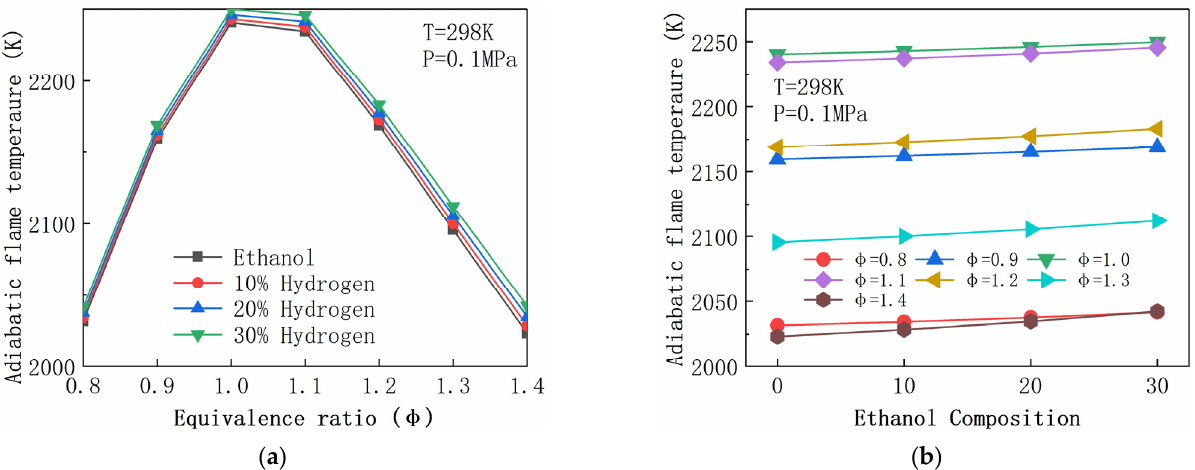
Figure 9. The AFT of ethanol − hydrogen − air flames at various ERs. ( a ) Different ERs. ( b ) Different ethanol compositions.